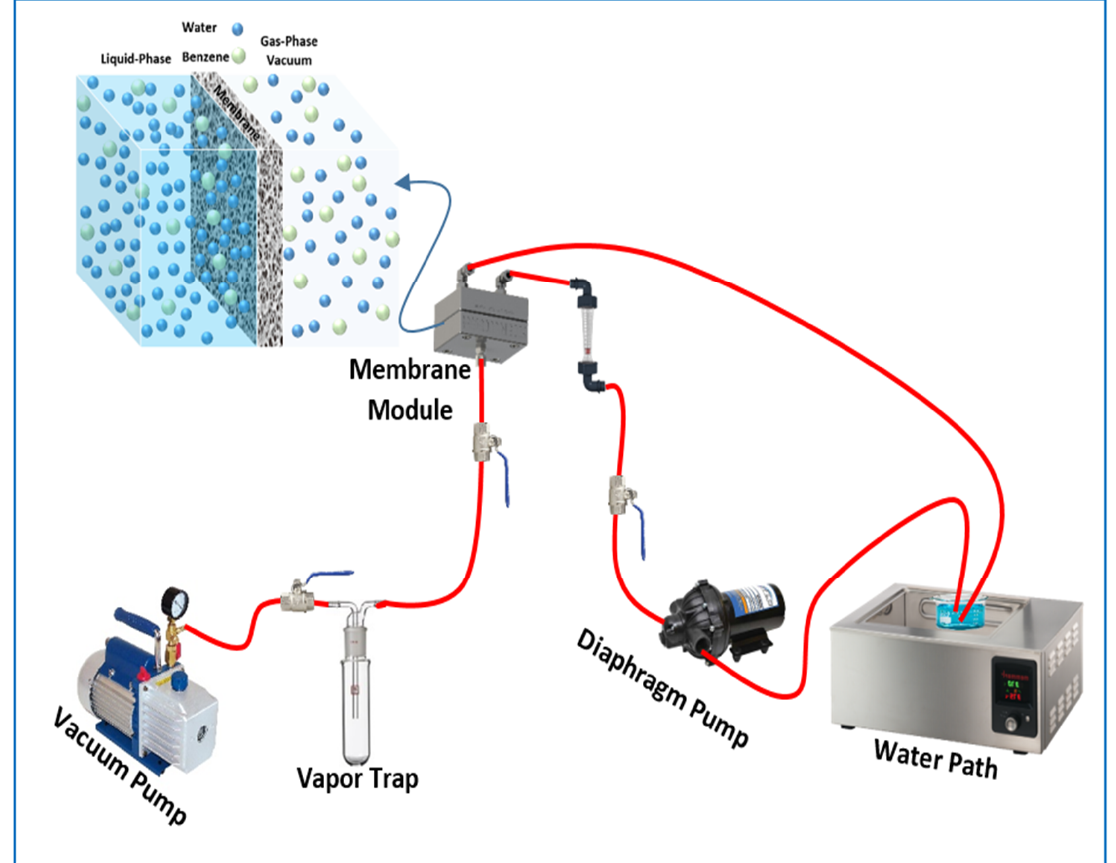
Figure 1. Schematic diagram of the pervaporation process.